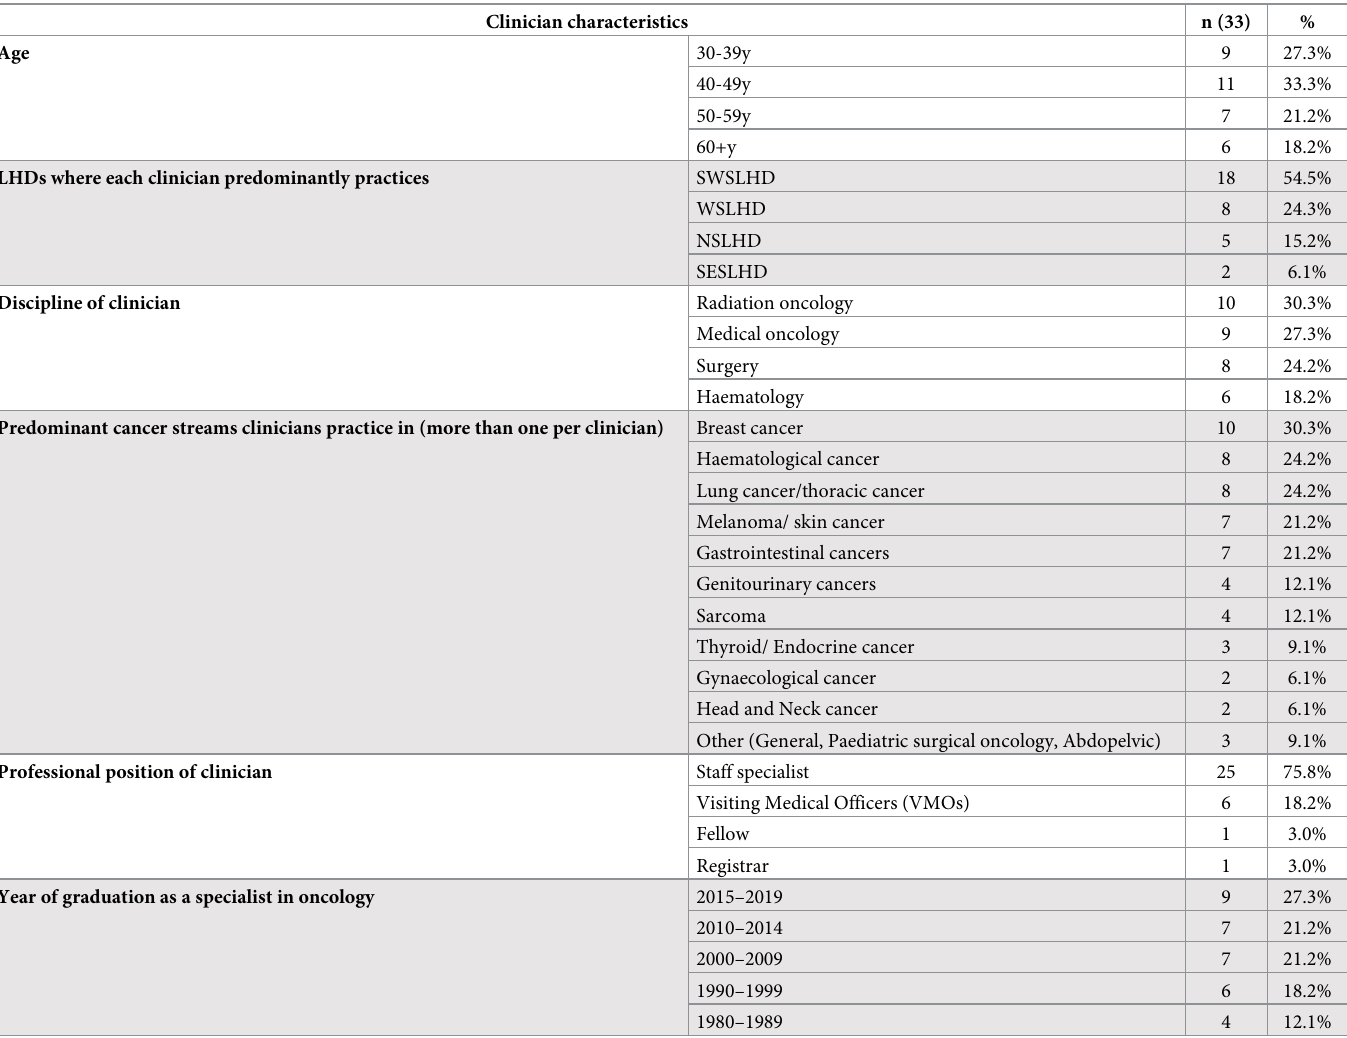
Table 1. Demographic data of interview